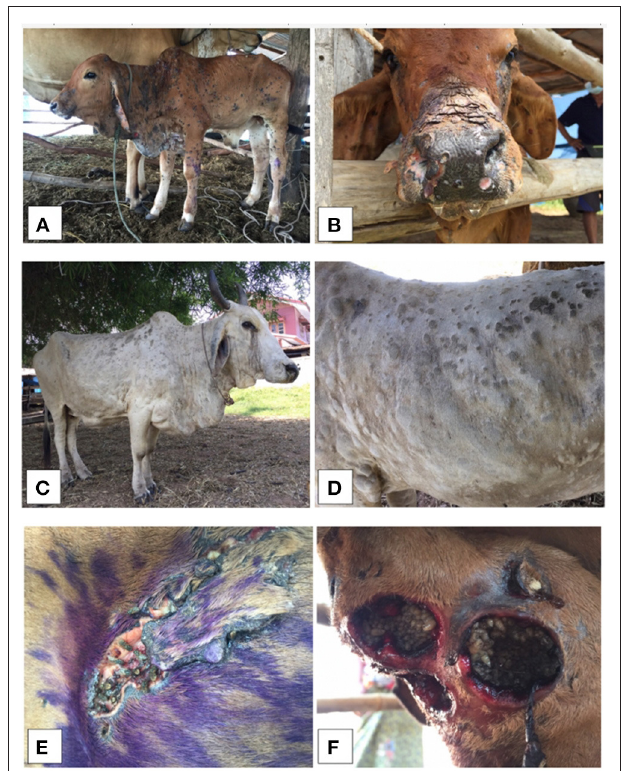
FIGURE 3 | Clinical signs from lumpy skin disease (LSD) affected cattle (A-D) illustrating the generalized nodules in calf (A,B) and adult cattle (C,D) . The LSD complications of skin nodules with stable flies and maggots were also shown, respectively (E,F) .